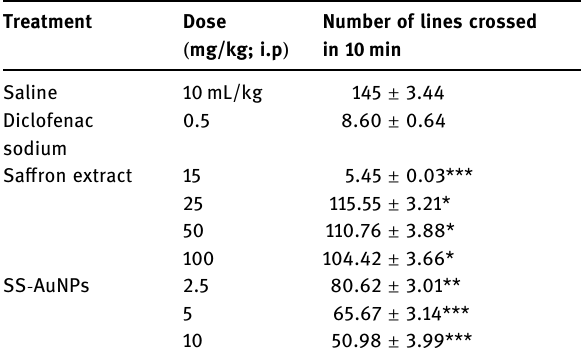
Table 6: Sedative activity of sa ff ron extract and SS - AuNPs Treatment Dose ( mg/kg; i.p )